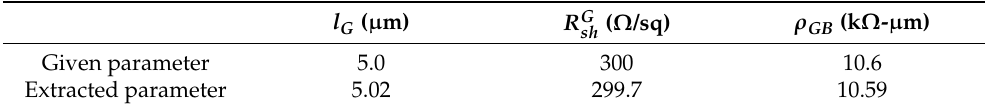
Table 1. Comparison of three-grain parameters given for the theoretical calculation with those extracted by the developed analytical resistance